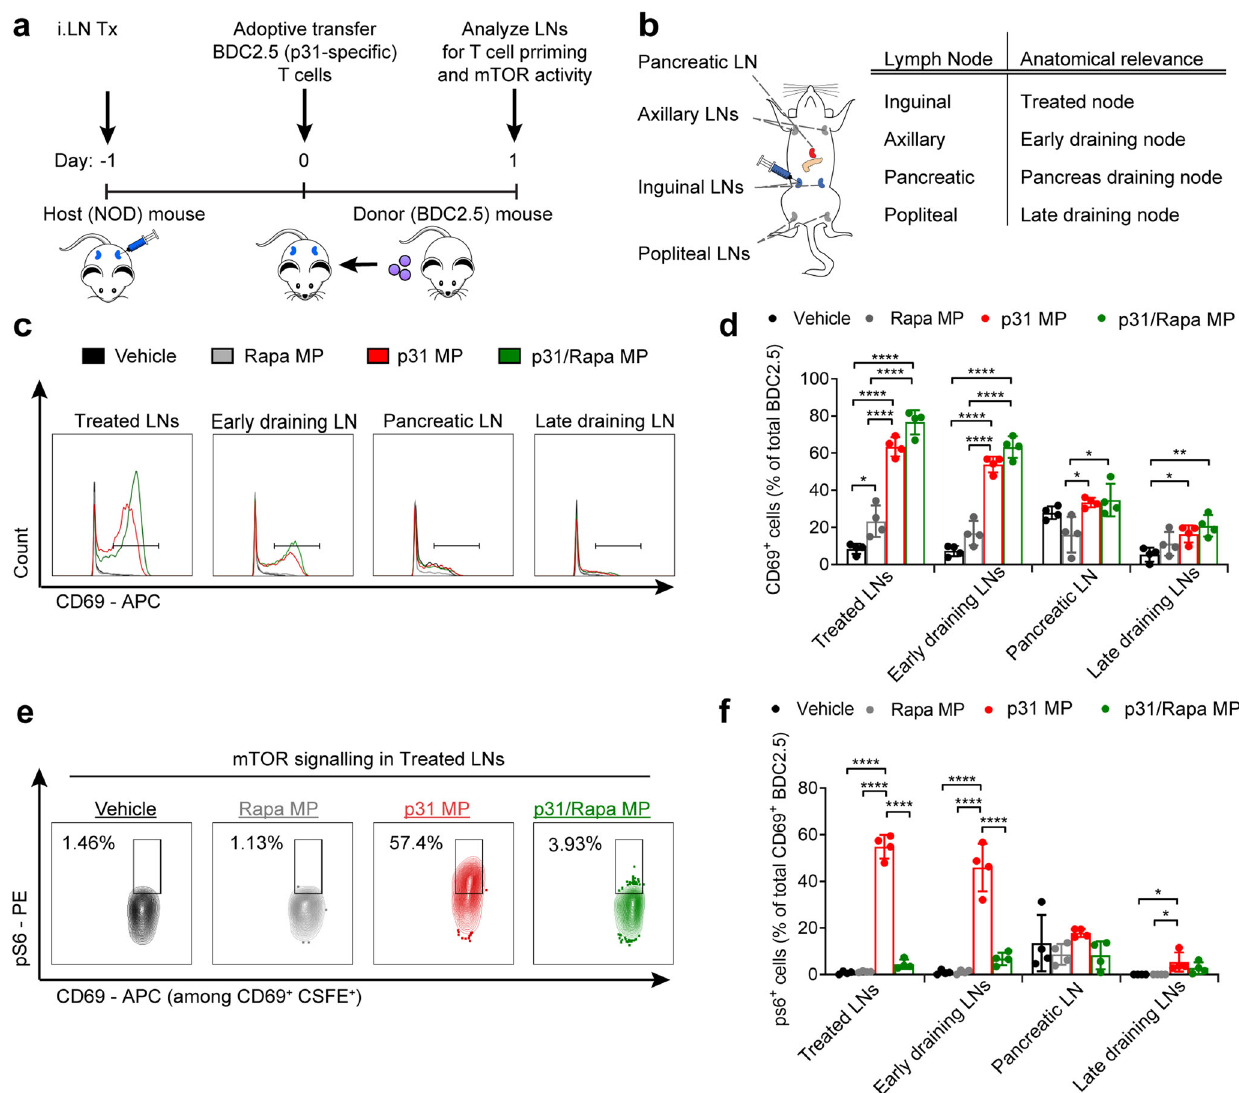
Fig. 4 | p31/Rapa MPs promote antigen-speci fi c T cell priming while inhibiting mTOR in vivo. a Schematic representation of MP treatment and experimental readout for BDC2.5 T cell adoptive transfer experiment. b Illustration of lymph nodescollectedandtheiranatomicalrelevancetotreatment. c Representative fl ow cytometry traces and d quanti fi cation of CD69 expression among p31 speci fi c Tcells. e Representative fl owcytometrytracesofphosphorylateds6amongCD69 +